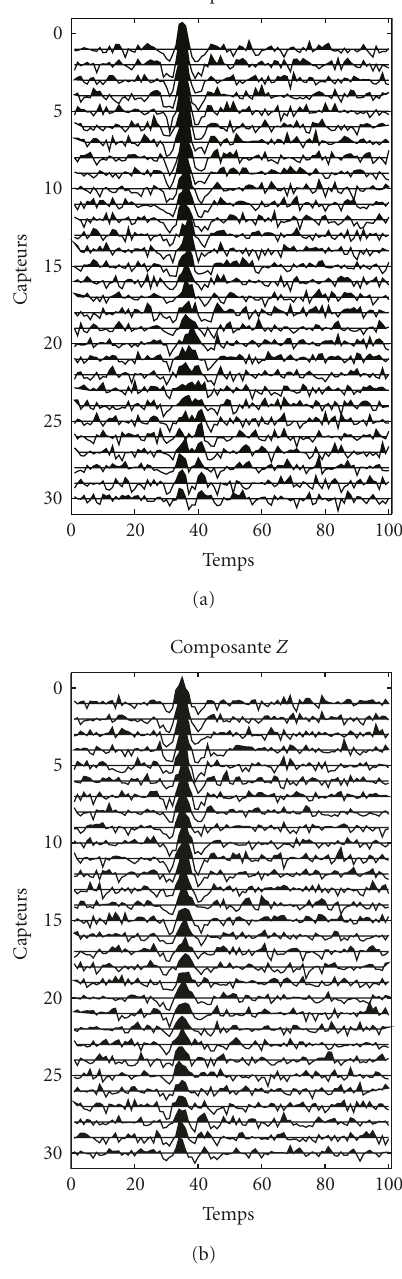
Figure 16: Initial noisy dataset.